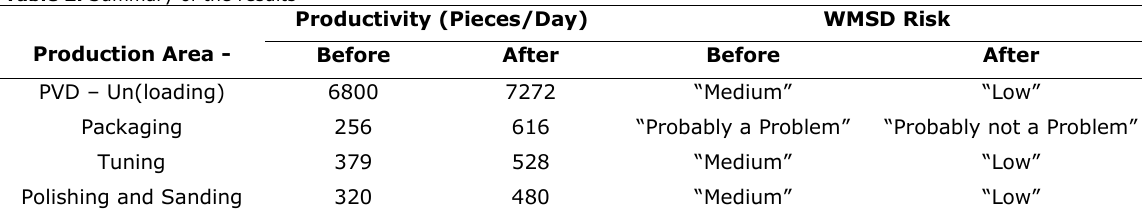
Table 2. Summary of the